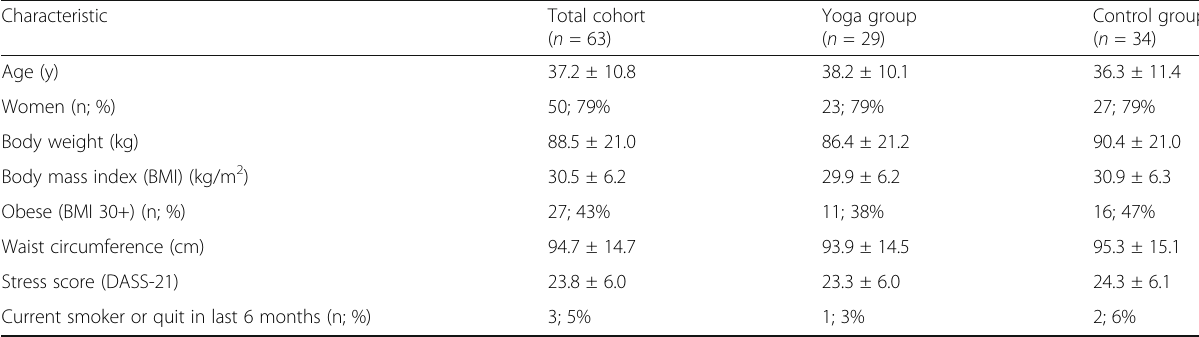
Table 1 Baseline